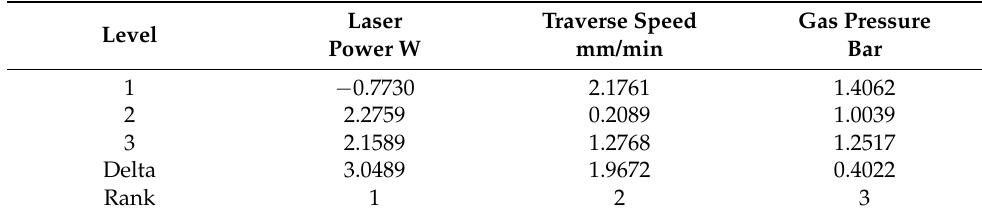
Figure 4. S/N ratio average value of input cutting parameters of the 4 mm thickness of sugar palm fiber reinforced unsaturated polyester (SPF-UPE) composite cut by laser beam cutting process. Table 11. S/N ratio response table of input cutting parameters of the 4 mm thickness off SPF-UPE composite cut by laser beam cutting process.